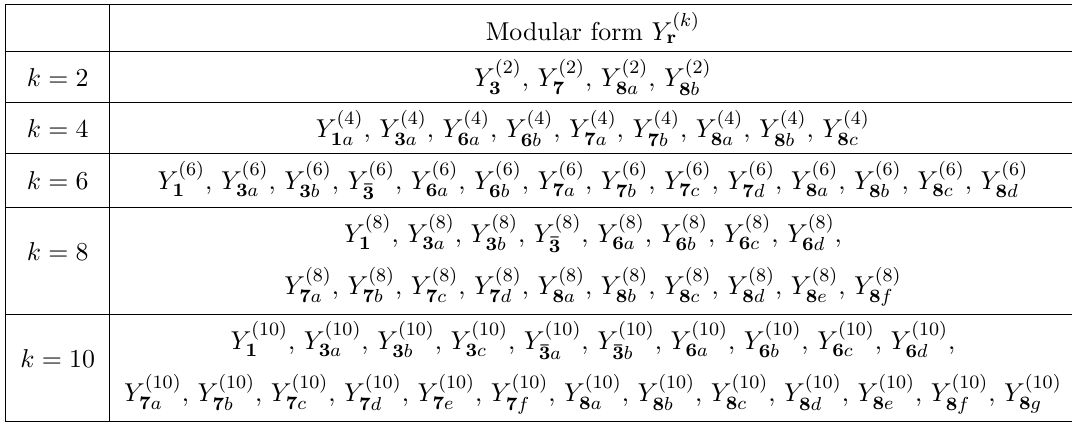
and Y (2) stand for two weight 8 a 8 b